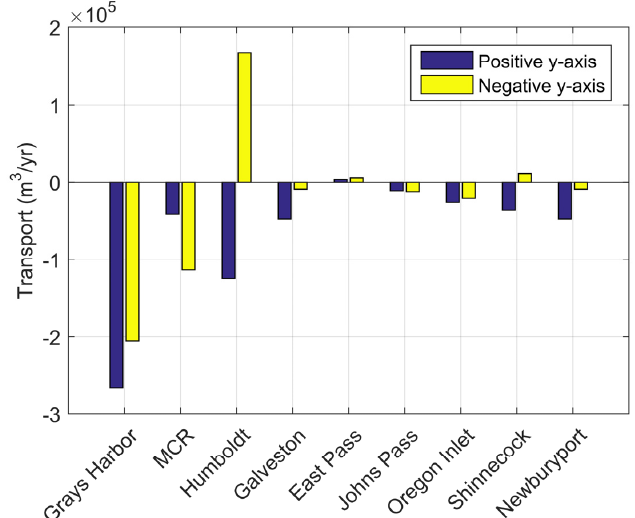
Figure 7 . Average longshore sediment transport bracketing the inlet entrance. The legend signifies the location where the transport is computed, i.e., positive ‐ y axis is above or on the upside of the inlet